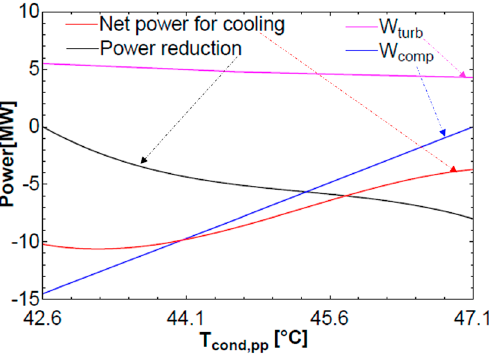
Figure 13. Compressor power, power reduction, turbine power output and net power for cooling to water-cooled baseline with varying power plant condensing temperature.